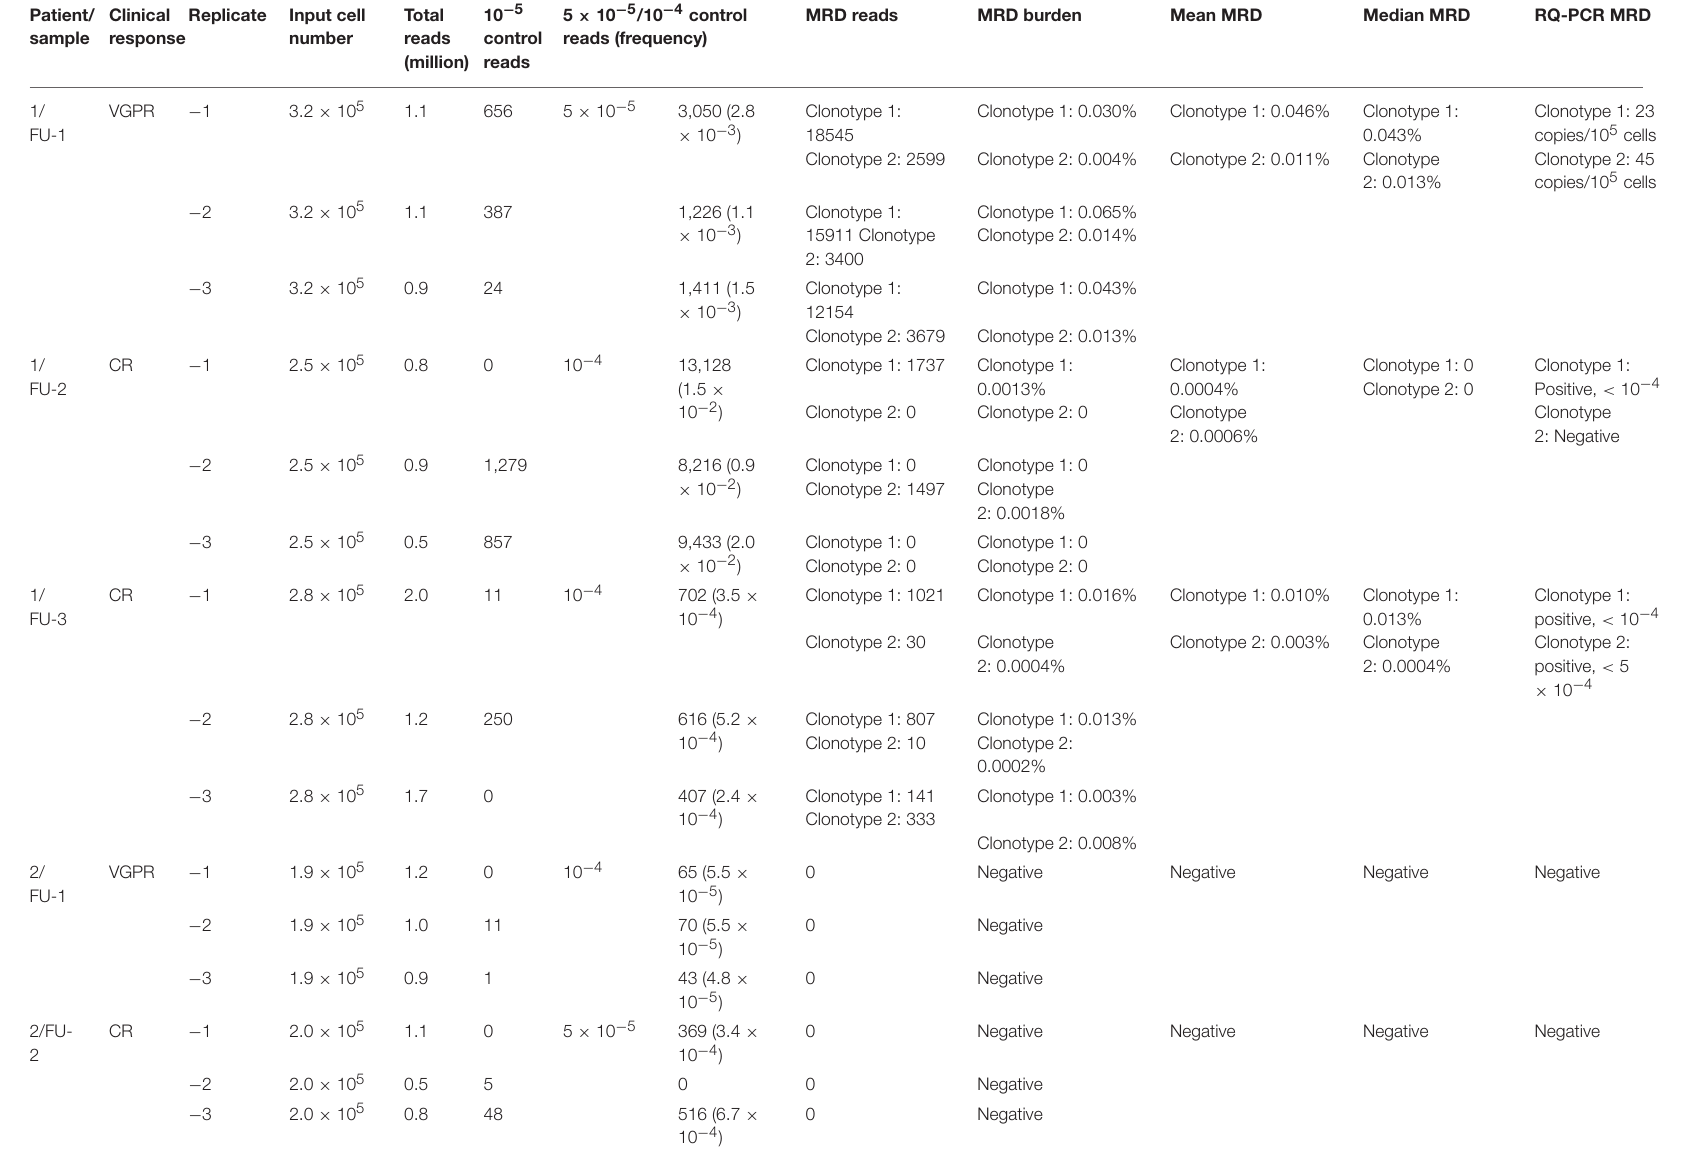
TABLE 3 | Results of minimal residual disease measured by next-generation sequencing and allele-specific oligonucleotide real-time quantitative-PCR. Patient/ Clinical responseReplicate Input cell sample